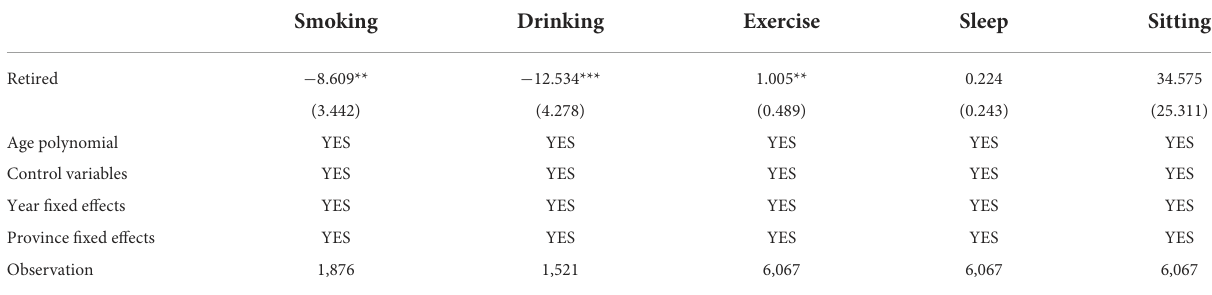
TABLE 9 Sensitivity test of window width 8.